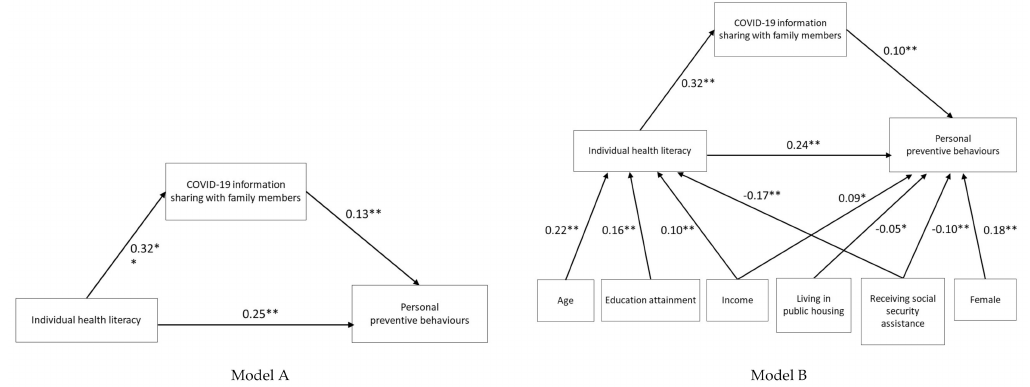
Figure 2. Standardized coe ffi cients from the structural equations model (Model A, unadjusted and Model B, adjusted) for assessing the mediating e ff ects of COVID-19 information sharing with family members on the relationships between individual health literacy and personal preventive behaviours. Note: The model was adjusted for sex, age and SES variables but only arrows with significant